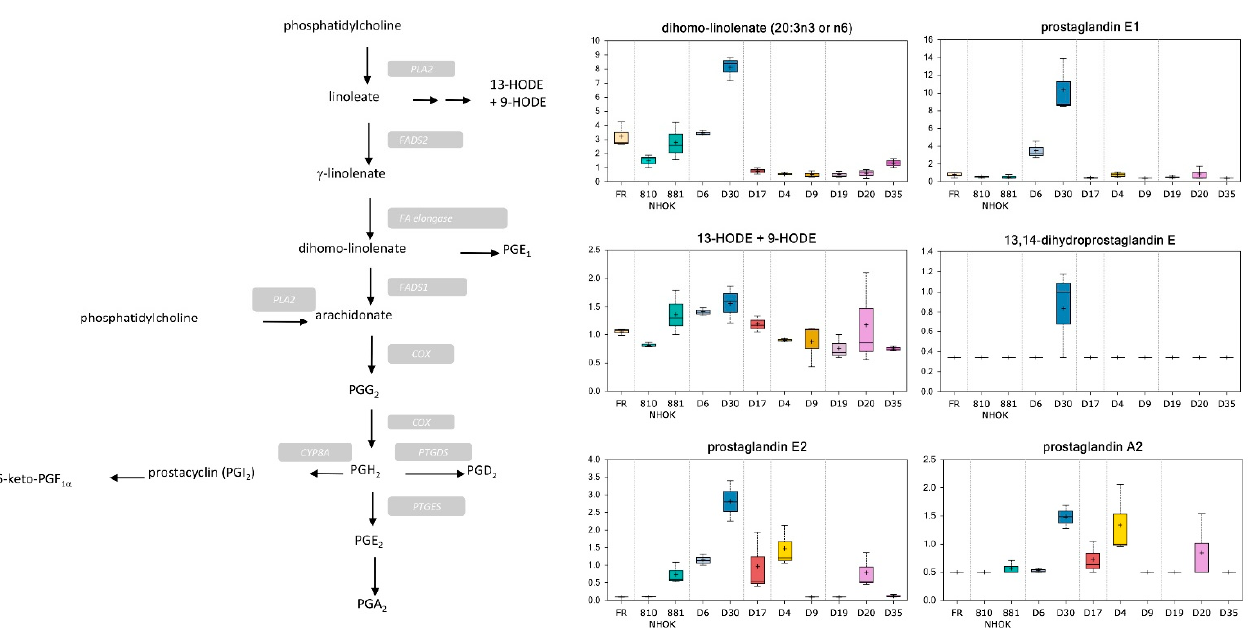
Figure 5. Alterations of prostaglandin metabolism in PPOL and normal keratinocytes. The symbols are the same as for Figure 3. Data represents the means of three independent experiments +/ − standard deviation. For statistical analyses see Supplementary Tables S3–S7. COX = cyclooxygenase; FADS = fatty acid desaturase; PLA2 = phospholipase A2; FA = fatty acid; CYP8A = Cytochrome P450 8A; PTGDS = Prostaglandin D synthase; and PTGES = Prostaglandin E synthase.